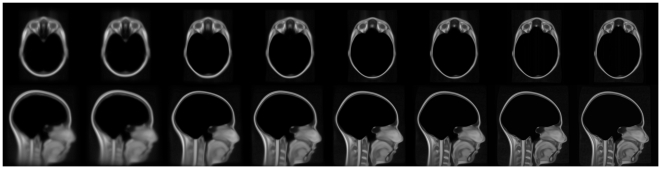
Population averages at each iteration in the hierarchical model
building process.For each step in the model-building process, axial (top row) and
sagittal (bottom row) views are shown. From left to right: The
9-parameter linear, 12-parameter linear, and each of the 6 nonlinear
models (from each step outlined in Table 1). Note the improved
contrast and structural resolution at each step in the model
building process.